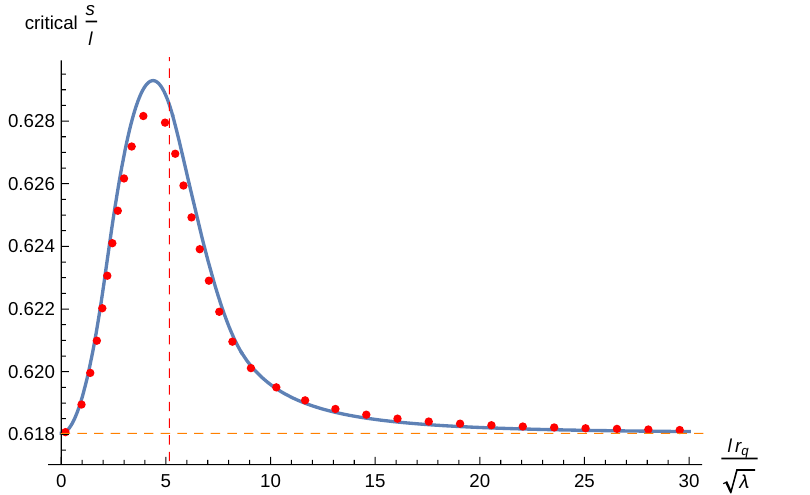
Figure 4 . Critical values of s=l for ^ (cid:15) = 0 : 1, at which the mutual information between strips of width l separated by a spacing s drops to zero. The dashed horizontal orange line denotes the critical value in a CFT. The numerical results (red dots) closely match the analytical results (blue curve; eq. (4.5)). Higher order in ^ (cid:15) corrections to (4.5) should produce an even closer match. The p vertical red dashed line is l q r q = (cid:21) where l q is the width of the strip whose bulk minimal surface just touches the